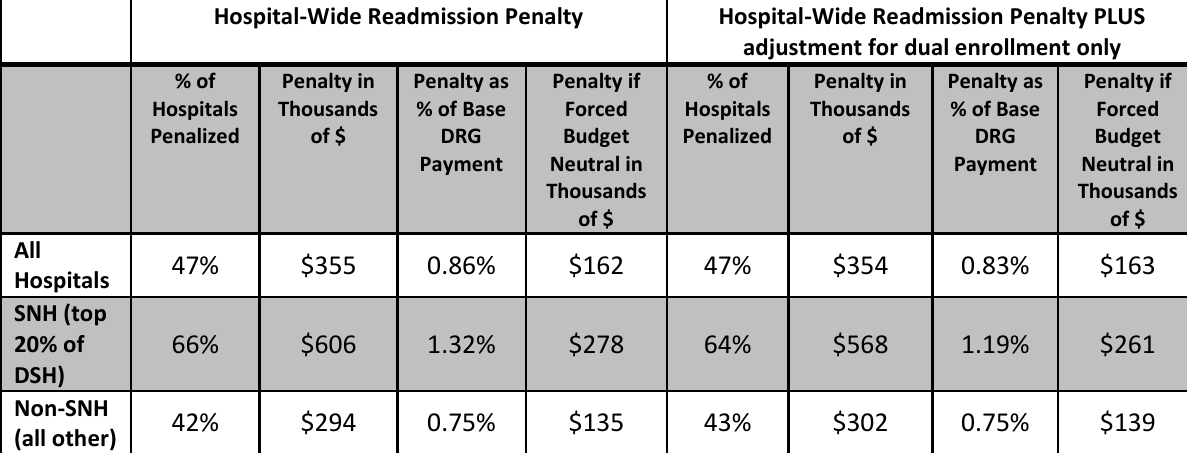
Table 5.14. Results of a Hospital-Wide Penalty and Adjustment for Dual Enrollment